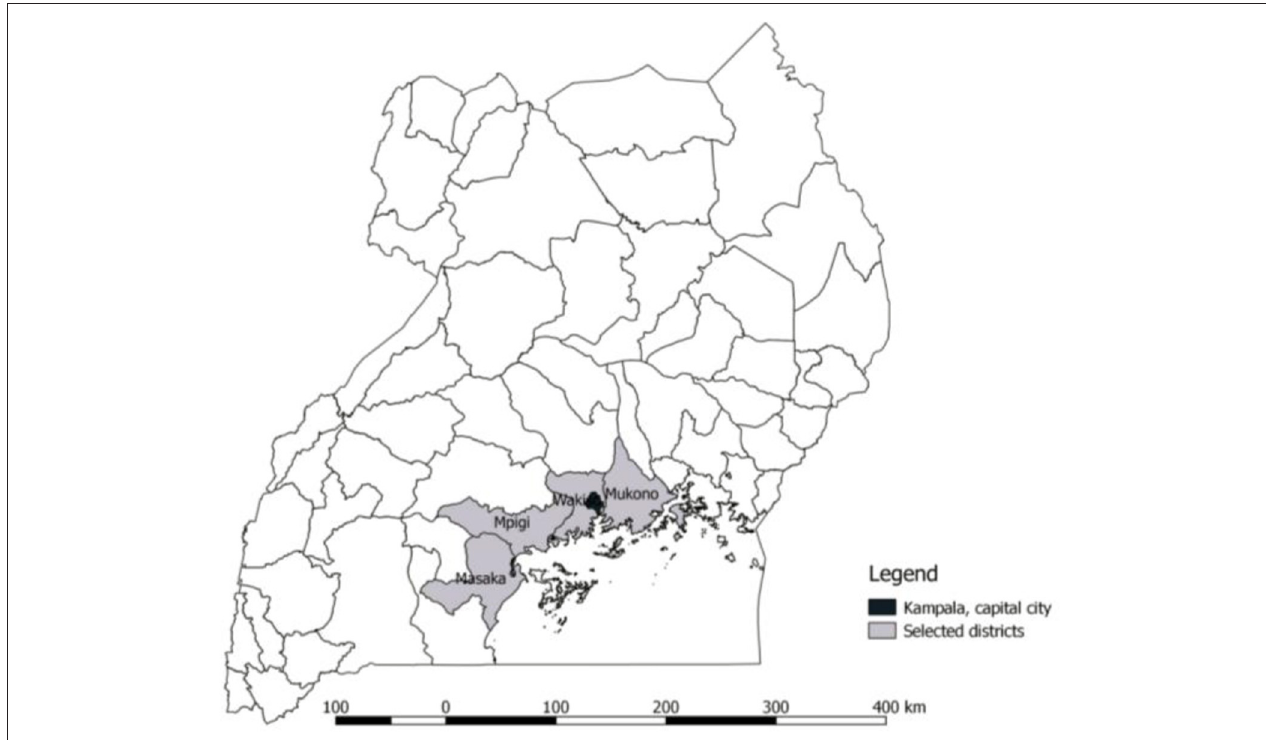
FIGURE 1 | Map of Uganda showing project sites (districts) where the study was